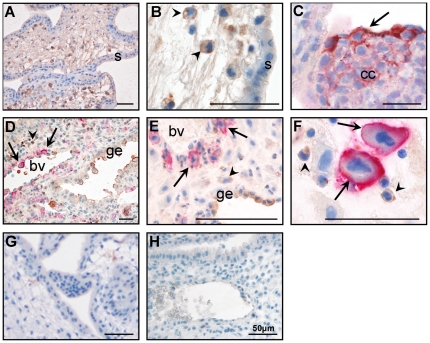
Profilin 1 (brown) and HLAG (pink) co-localization in placental villous (A–C) and decidua basalis (D–F).A. Profilin 1 localized to cells within the stroma of the villous tip, but not the syncytiotrophoblast (s). B. Profilin 1 localized to leukocytes (arrowheads) in the villous tips. C. Profilin 1 and HLAG co-localilzed to extravillous trophoblast (EVT, arrow) in the cell column (cc). D. Profilin 1 localized to the glandular epithelium (ge), and HLAG positive cells (EVT, arrows) surrounding blood vessels (bv) and HLAG negative cells (arrowheads) in the decidua basalis. E. Profilin 1 localized to the ge, EVT (arrows) and HLAG negative cells (arrowheads) in the decidua basalis. F. Profilin 1 and HLAG co-localizaation to EVT (arrows) in the decidua basalis. Profilin 1 was also expressed on leukocytes (HLAG negative cells, arrowheads). G. Negative (IgG) control for placental villous tissue. H. Negative (IgG) for decidua. Scale bar: 50 µm.